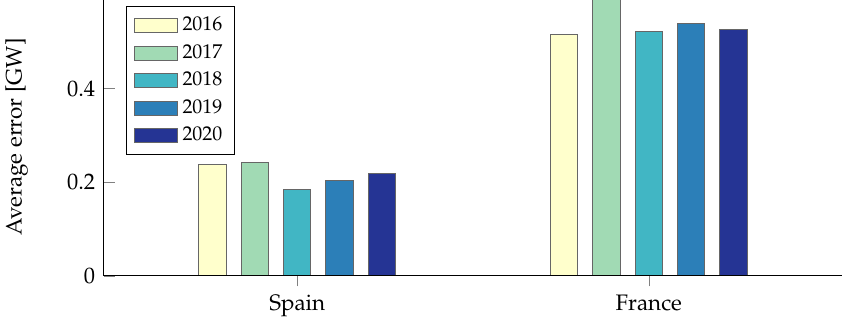
Figure 5. Average daily load forecasting error in Spain and France, between 1 January